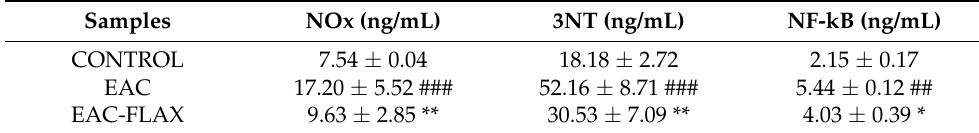
Table 7. Ascites anti-inflammatory markers at the end of the